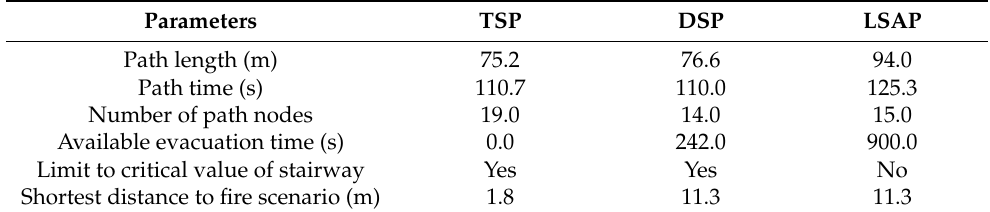
Table 10. Comparative analysis of the parameters of different evacuation passageways in summer.